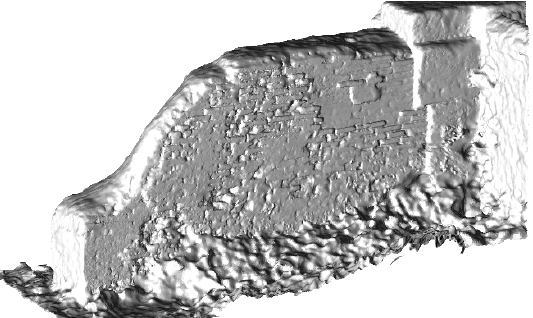
Fig. 21 A geometric detail of a image-based 3D model wall, shaded in